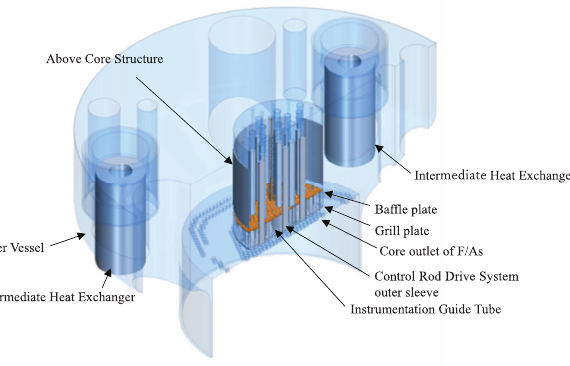
Fig. 5. Bird’s eye view of CFD